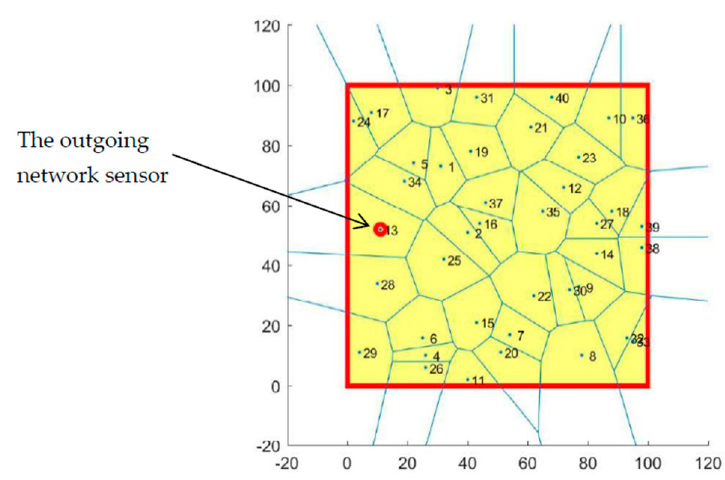
Figure 8. Voronoi cells of the 40 deployed sensors.